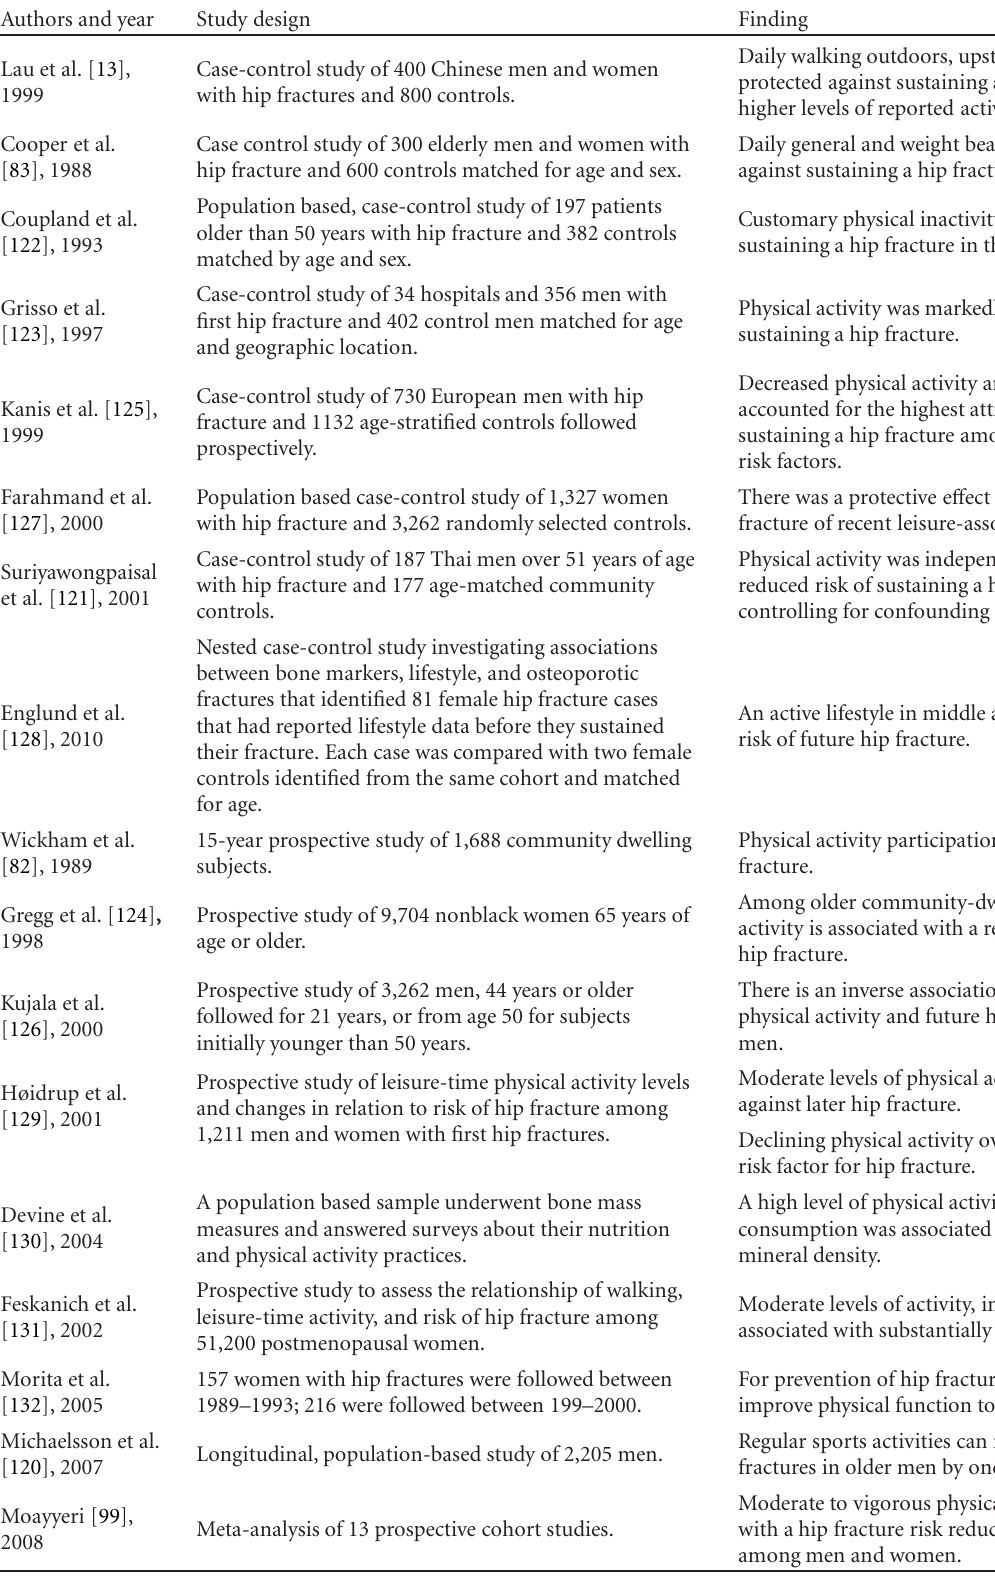
Table 3: Over 20-years of research evidence showing degree of physical activity participation is a consistent predictor of hip fracture risk in the context of cross-sectional (Level III), case control (Level III), systematic reviews and prospective (Level II) studies as categorized according to Oxford Centre for Evidence-Based Medicine quality